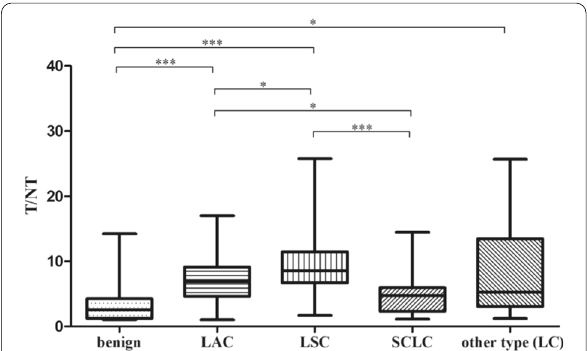
Fig. 3 Ratio of primary tumour to normal tissue (T/NT) in different groups. * p < 0.05; ** p < 0.01; *** p <